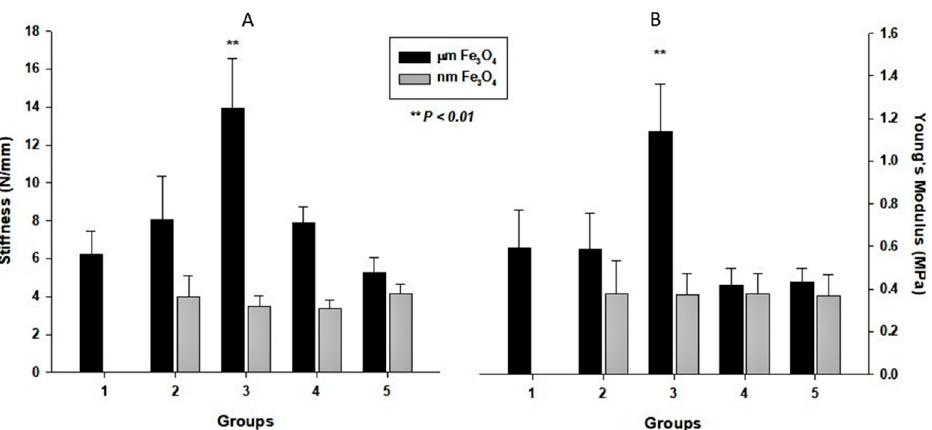
Figure 2. Mechanical properties of the prepared scaffold samples: Panel ( A ) exhibits the stiffness results of the samples; panel ( B ) shows the Young’s modulus results of the samples. Black column #1 is the pure PCL scaffold, black columns #2–#5 are samples with micron-sized Fe 3 O 4 ( µ m-2 to µ m-5 in sequence), and white columns are samples with nano-sized Fe 3 O 4 (nm-2 to nm-5).